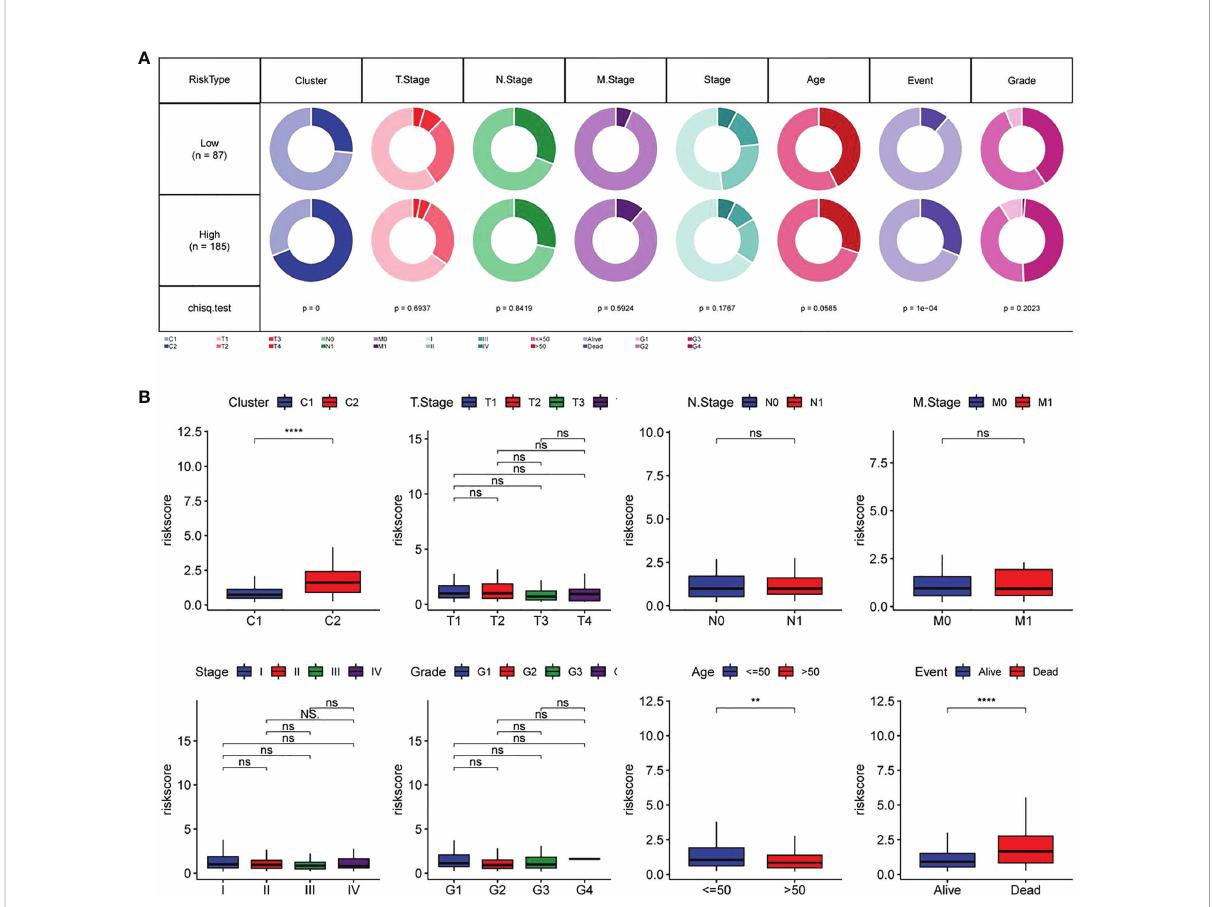
FIGURE 9 Relationship between RiskScore and different clinicopathological features of CC patients (A) Comparison in terms of the distribution of different clinical characteristics between high-and low-risk groups in TCGA data sets; (B) Differences in RiskScore of different clinical characteristics in